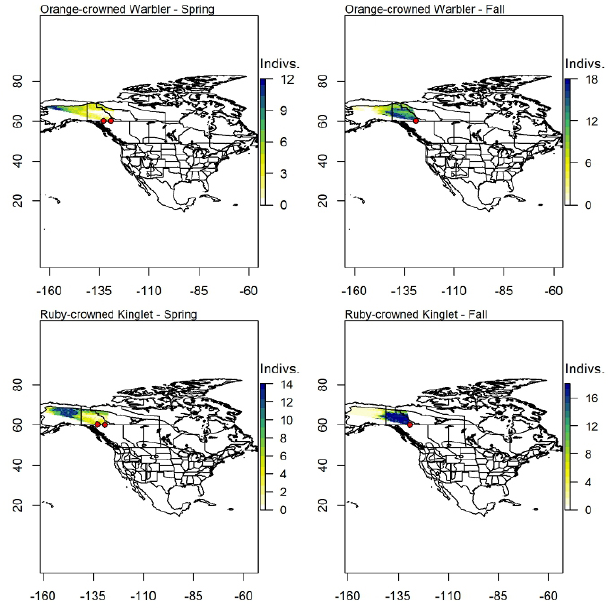
Fig. 9 . Probable origins of Orange-crowned Warbler ( Oreothlypis celata ) and Ruby-crowned Kinglet ( Regulus calendula ) captured in Yukon Territory during spring and fall migration. Red dots indicate locations of Canadian Migration Monitoring Network stations used in the analysis. Scales indicate the number of individuals that were isotopically consistent with similarly colored pixels in the map given.